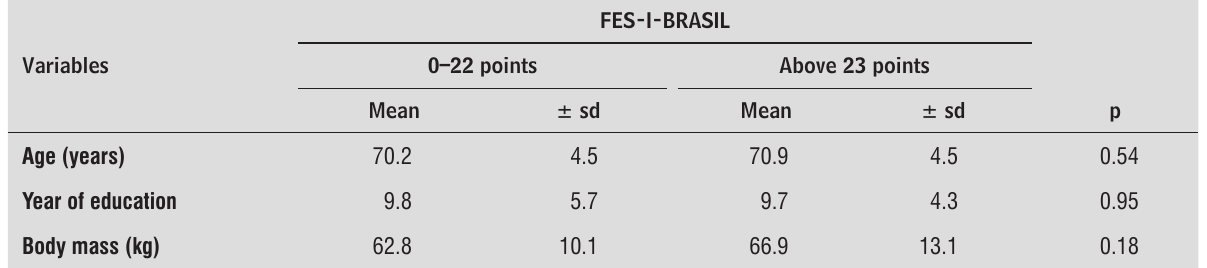
Table 2 - Mean and standard deviation (± sd) of the independent variables according to self-efficacy of falls in the Community-dwelling elderly women of Natal, RN,